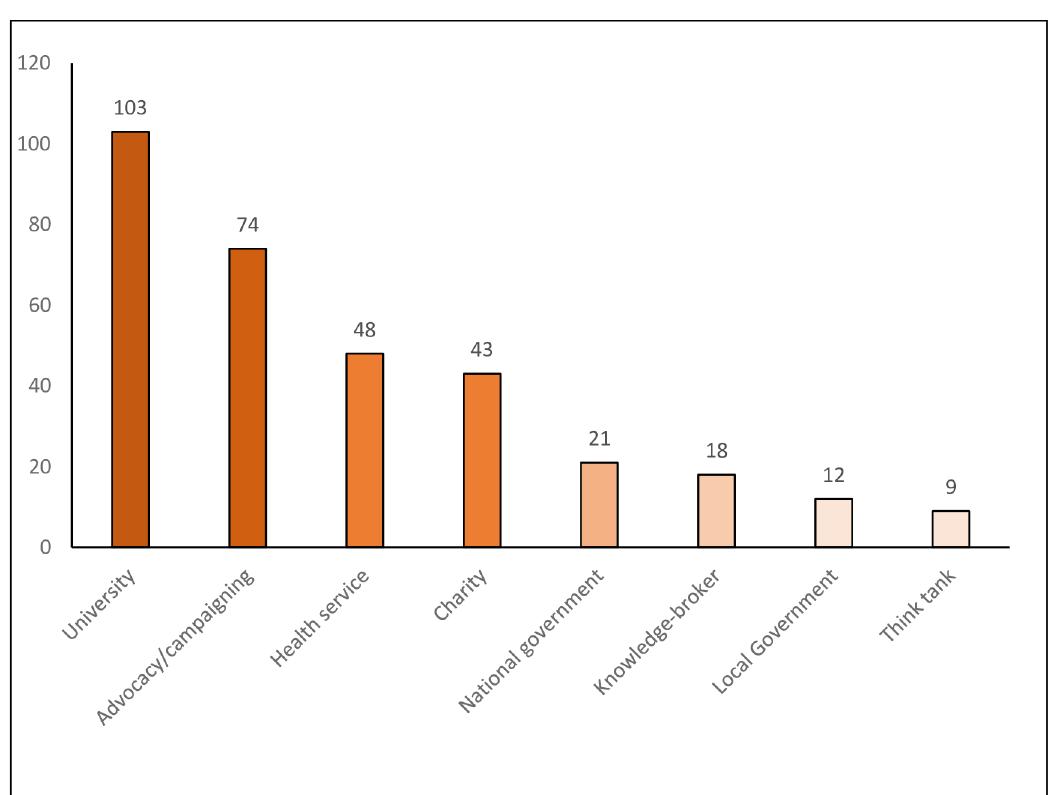
Fig 2. Institutional affiliation of respondents (number of respondents in each